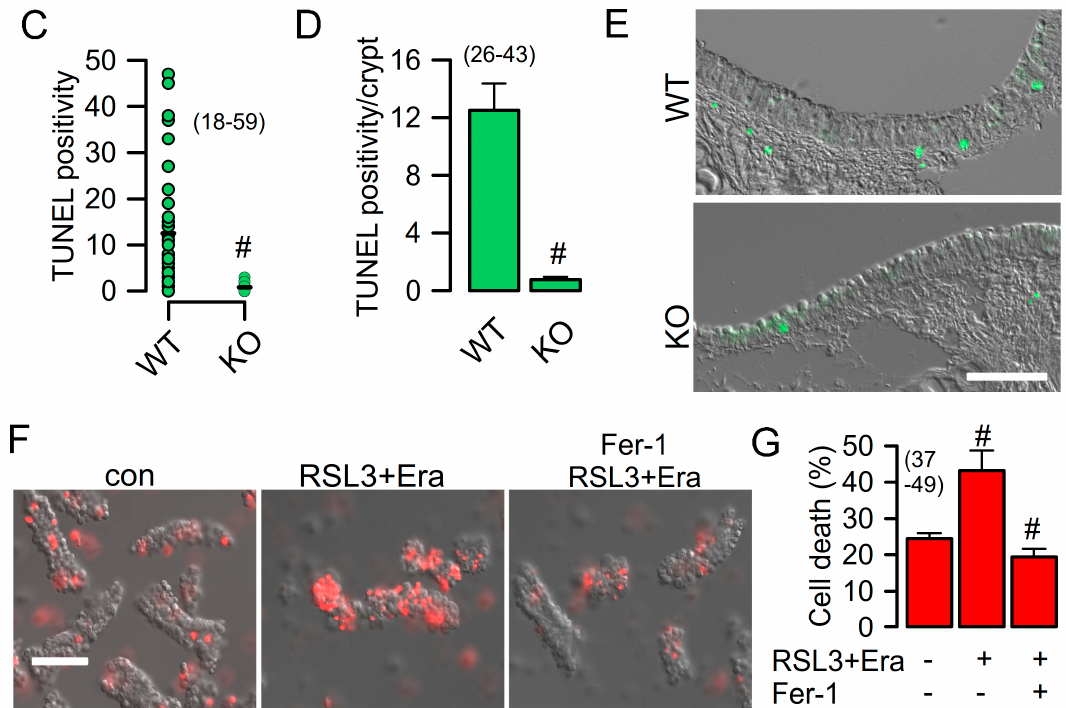
Figure 1. Attenuated cell death in epithelial cells from mice lacking expression of TMEM16F. ( A ) TUNEL staining in intestinal epithelium of mice with intestinal epithelial specific knockout of TMEM16F (TMEM16F fl / fl -Vil1-Cre; KO) and WT littermate controls (TMEM16F fl / fl ; WT). Bar = 100 µ m. ( B ) RT-PCR indicating lack of expression of TMEM16F in isolated crypts of TMEM16F knockout animals. ( C , D ) Summary of the number of TUNEL-positive crypts per section and the number of TUNEL-positive cells per individual crypt, respectively. ( E ) TUNEL positive cells in airways of WT mice and mice with airway epithelial specific knockout of TMEM16F [31]. Bar = 50 µ m. ( F , G ) Propidium iodide staining in isolated mouse crypts and activation of ferroptosis by RSL3 (1 µ M) and erastin (5 µ M) (RSL3 + Era). Inhibition of ferroptotic cell death by ferrostatin-1 (Fer-1; 5 µ M). Bar = 100 µ m. Mean ± SEM (number of experiments). # significant di ff erence compared to WT, con, or RSL3 + Era, respectively ( p < 0.05, unpaired t -test).